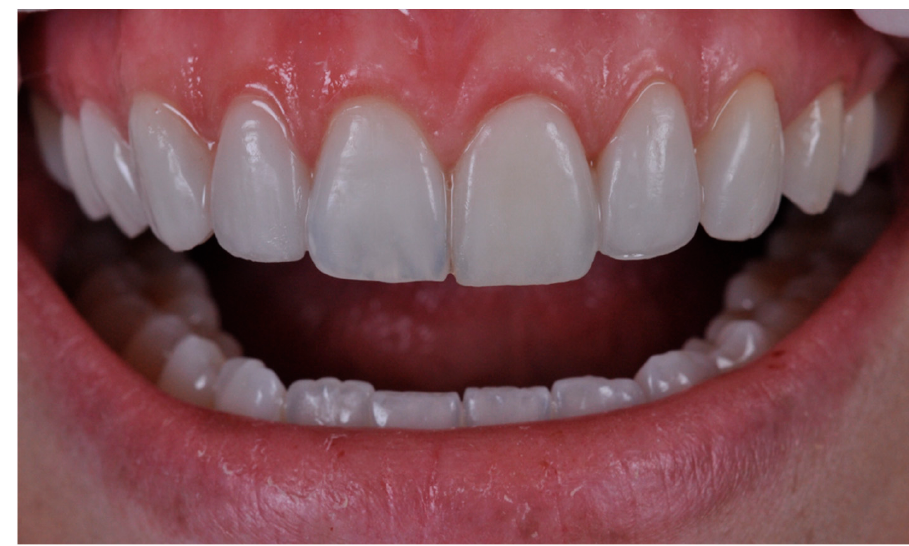
Figure 6. Immediate photo after luting and polishing procedures in frontal smile.